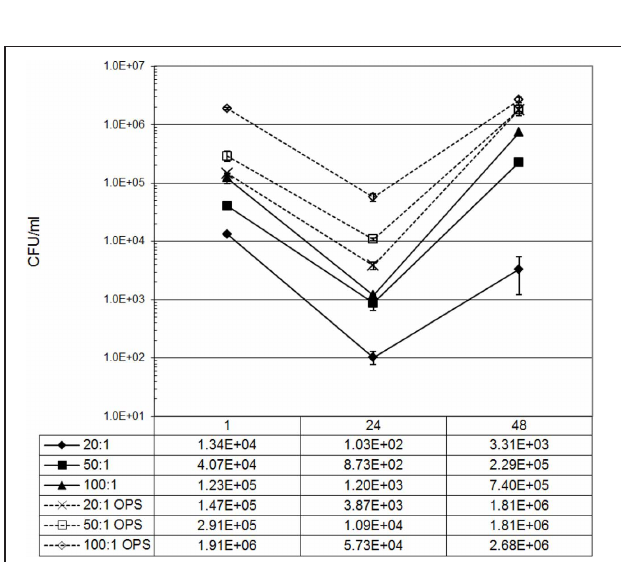
FIGURE A1 | Internalization and intracellular viability of IgG opsonized and non-opsonized B. abortus . Monolayers of Raw264.7 cells were infected with increasing concentrations of IgG-opsonized or non-opsonized B. abortus . The average CFU per time point illustrates the correlation between the amount of Brucella internalized following infection, and the rate of Brucella replication and survival. To compare results from opsonized and non-opsonized Brucella , remaining experiments were normalized to numbers of Brucella taken up by cells using MOI’s of 20:1 for ops and 100:1 for non-ops. Results presented were calculated from samples performed in triplicate and confirmed by separate independent experiments.